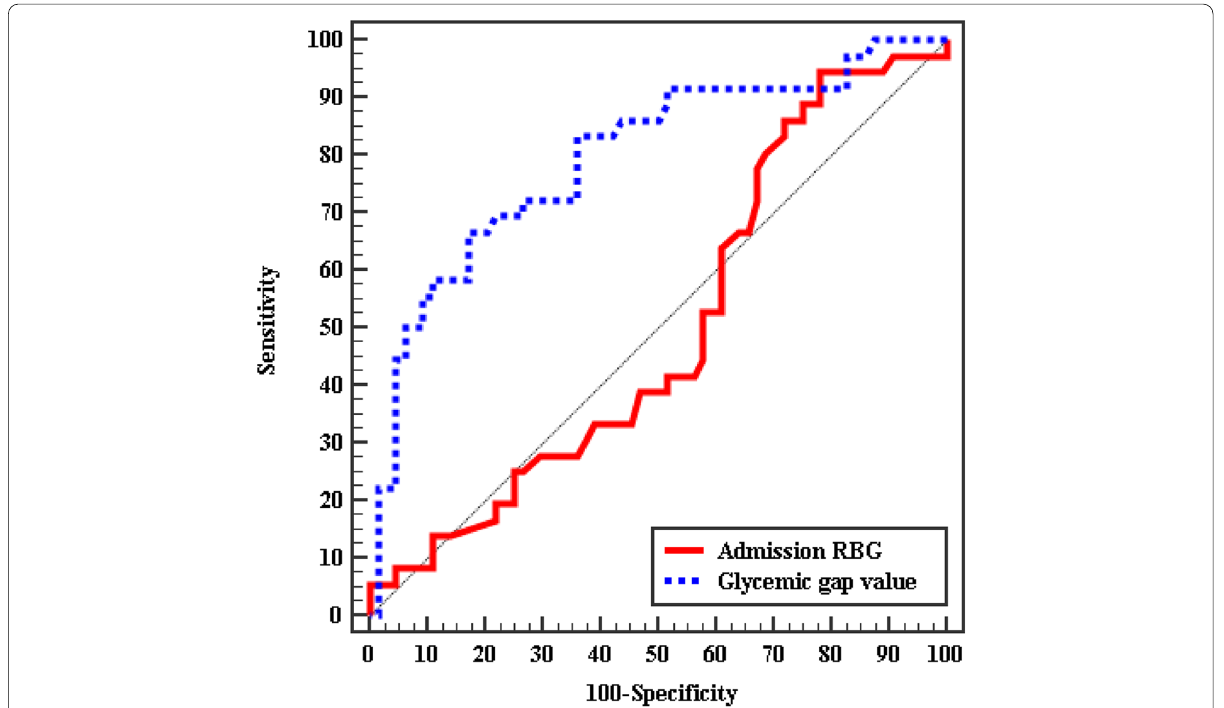
Fig. 3 ROC curve for admission RBG and glycemic gap value to predict MACE